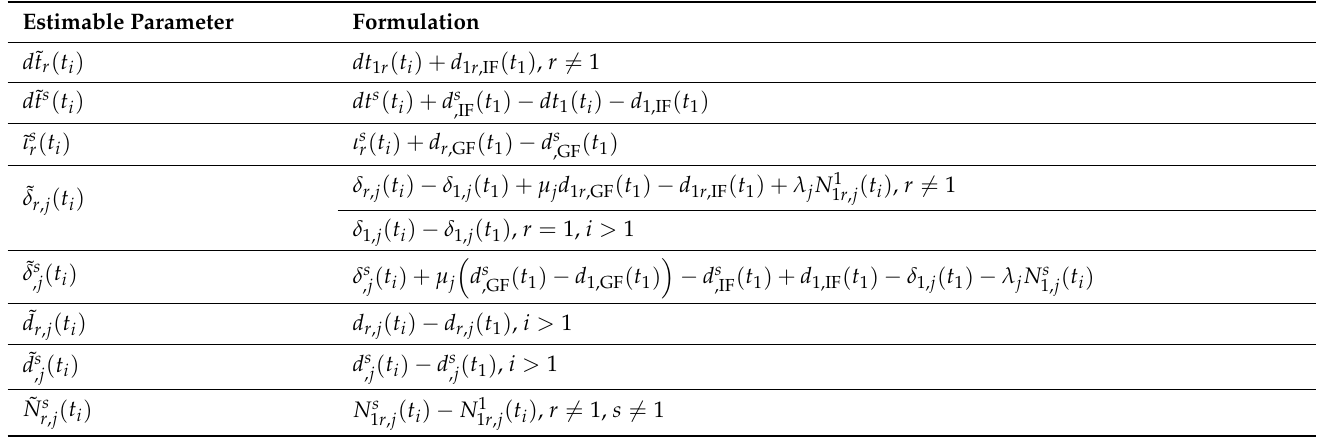
Table 1. Estimable parameters in the undifferenced and uncombined network processing. The ZTDs, hardware biases and ambiguities are linked in